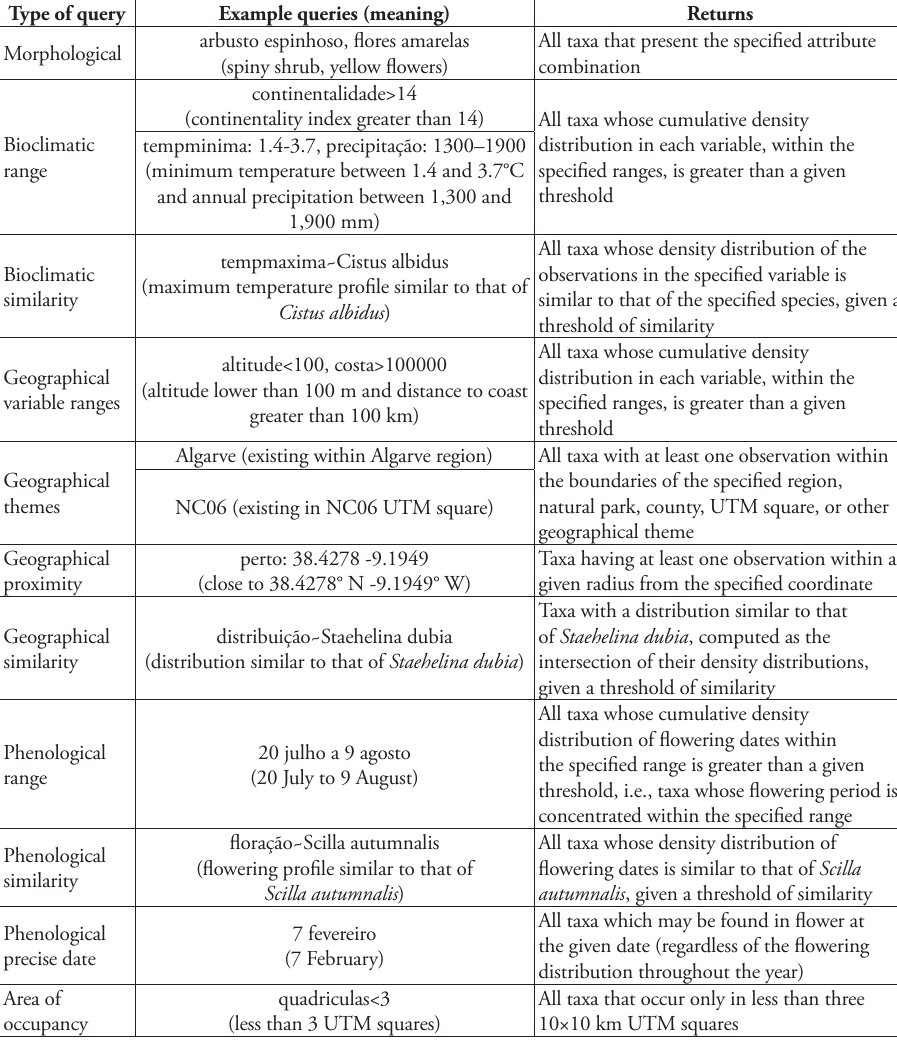
Table 1. Example of query types which can be entered by users into the Flora-On search box. Any comma-separated combination of queries can be entered into the search box. Currently, Flora-On only accepts queries in Portuguese. The table provides the English translation in